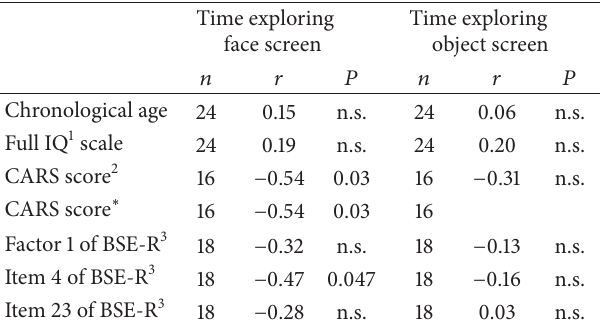
Figure 3: Time exploring face screen and time exploring object screen in children with ASD and controls. Table 3: Clinical correlates in autism